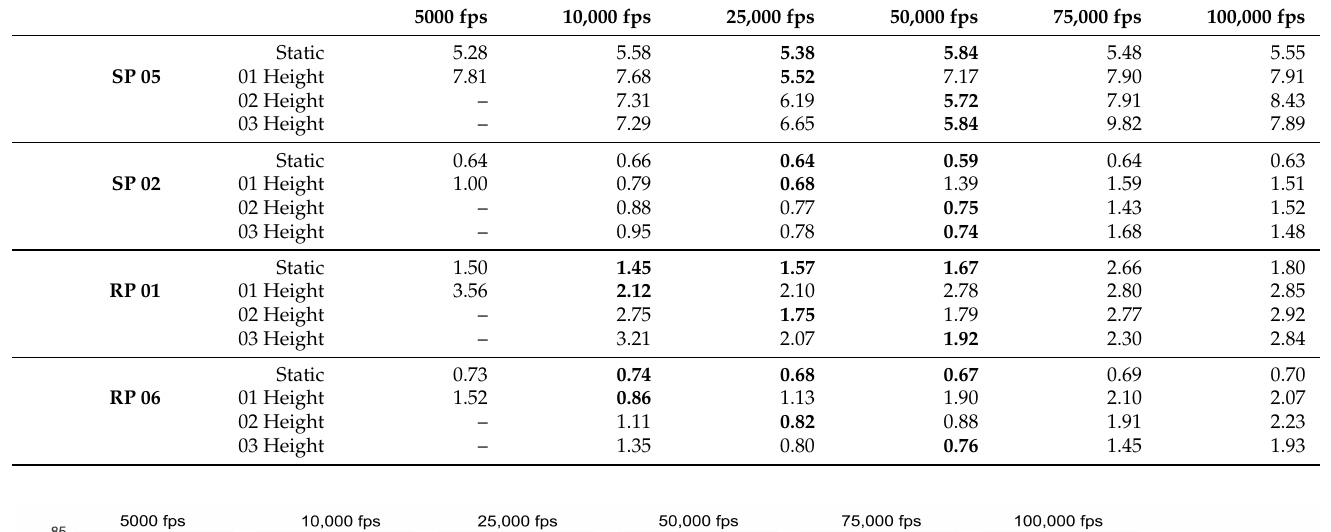
Table 3. Median s 0 in [ µ m] for the best- and worst-performing SPs and RPs. Depending on experimental configuration, the lowest s 0 values are marked in bold.